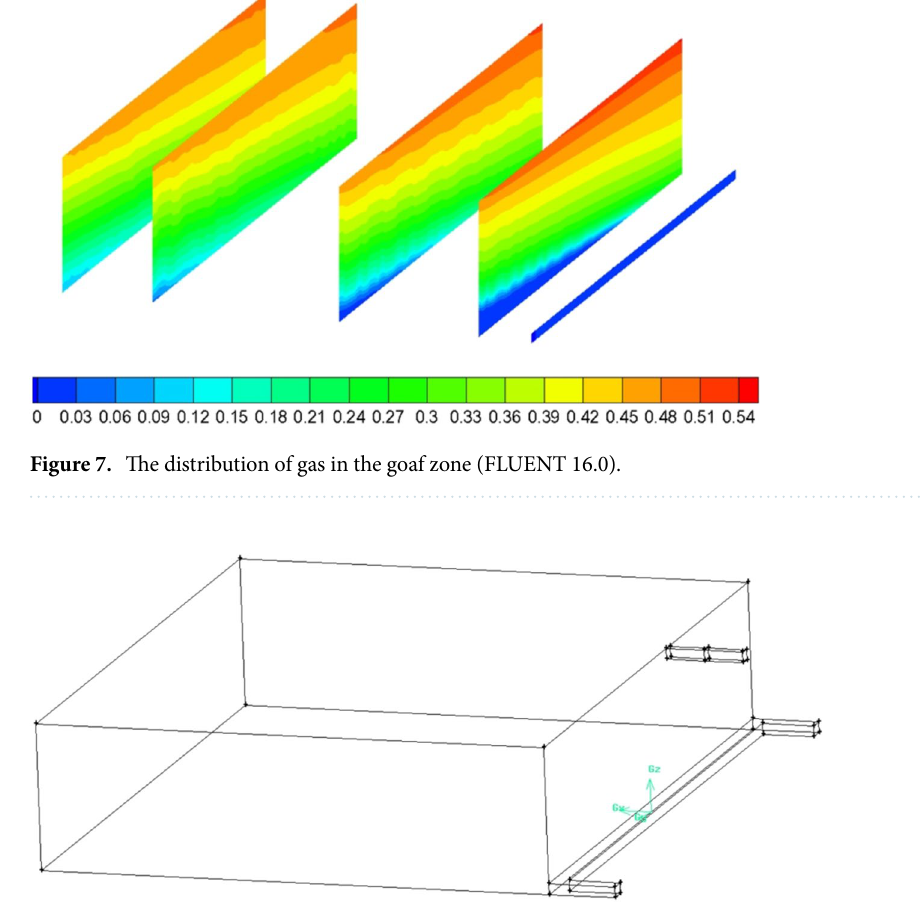
Figure 8. The geometric model of roof low roadway (FLUENT